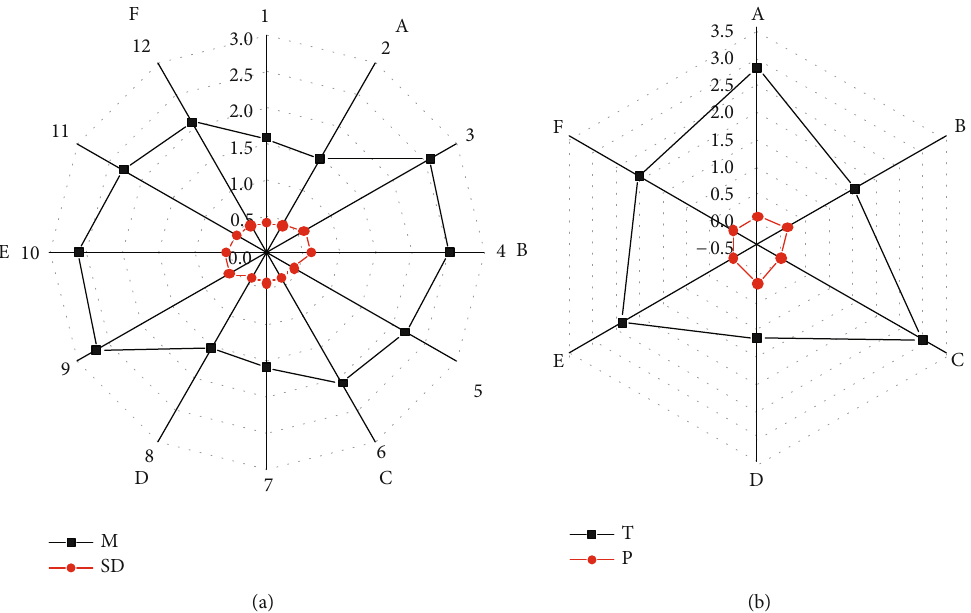
Figure 9: Comparative results of parenting styles of college students of only-child and non-only-child family: (a) mean and standard deviation of descriptive statistics; (b) t values and P values for descriptive statistics; 1, 3, 5, 7, 9, and 11: boys; 2, 4, 6, 8, 10, and 12: girls; A: father ’ s rejection; B: father ’ s emotional warmth; C: father ’ s overprotection; D: mother ’ s rejection; E: mother ’ s emotional warmth; F: mother ’ s